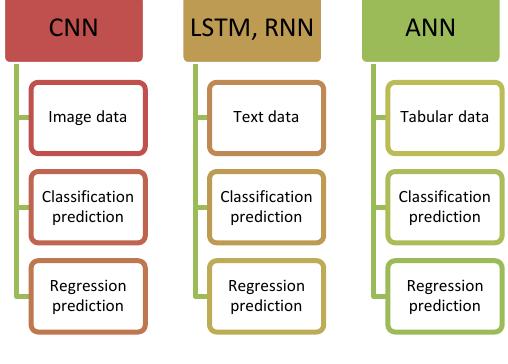
Figure 9. The AI algorithms used to solve our problem